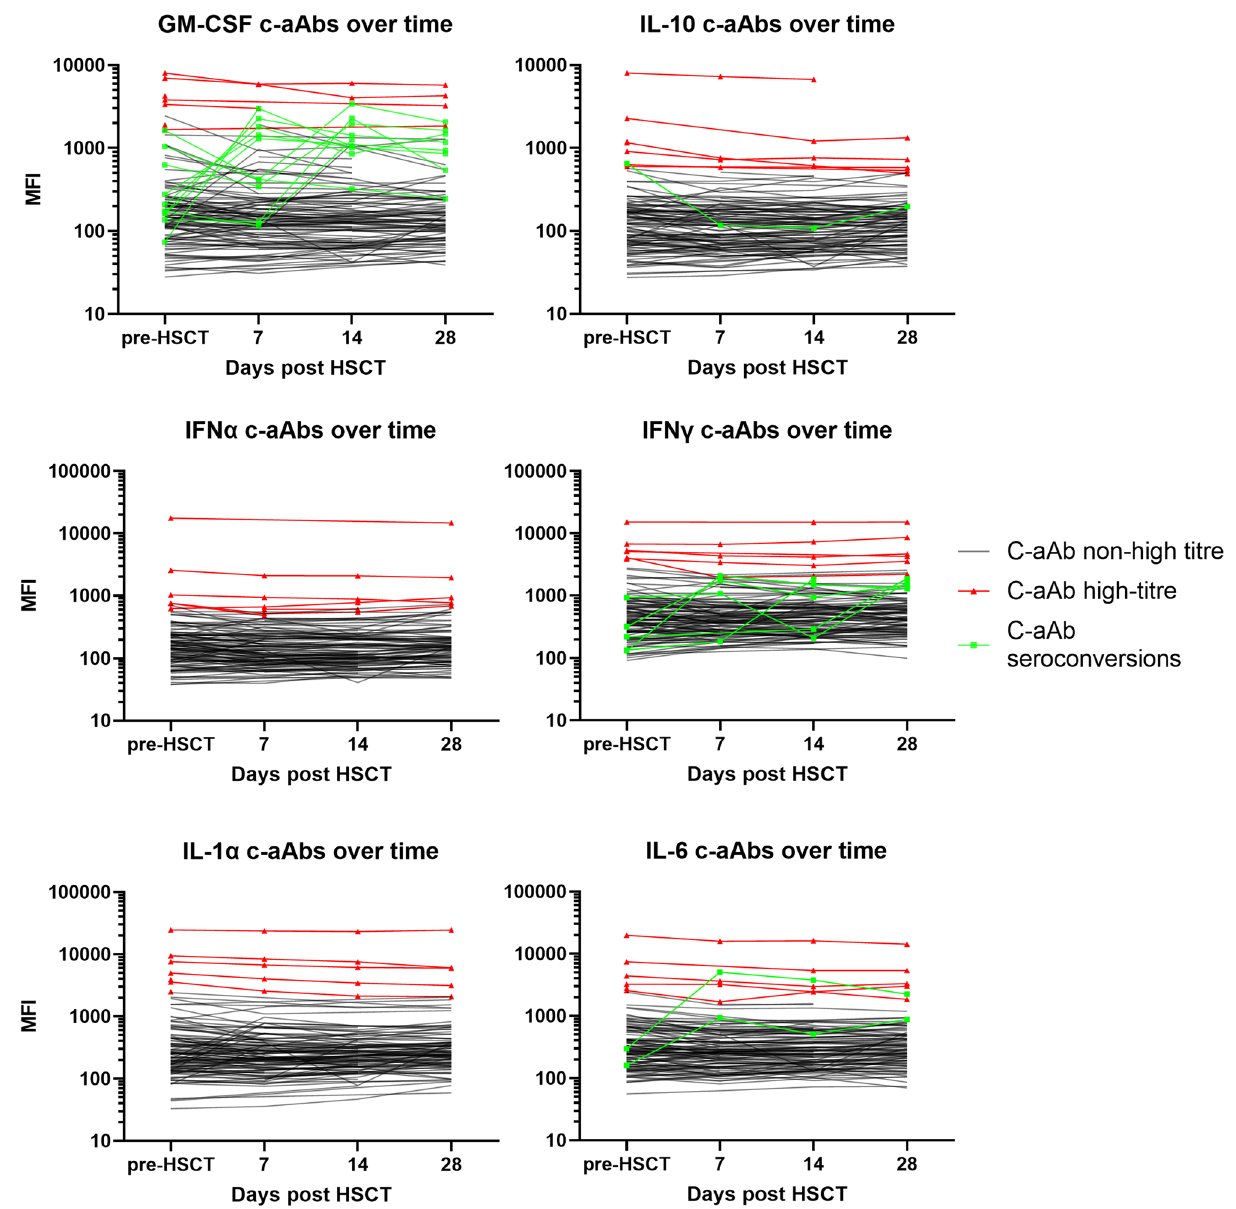
Figure 1. Cytokine autoantibody levels over time. C-aAb levels for all patients (n = 131) during HSCT (each line represents one patient). Patients who were classified as having high-titre c-aAbs (≥ 95th percentile for a person’s average MFI score) are coloured red with triangle icons. Patients with seroconversions, defined as maximum observed c-aAb MFI > 90th percentile and a (maximum c-aAb MFI/minimum c-aAb MFI) factor difference of ≥ 5, are coloured green with square